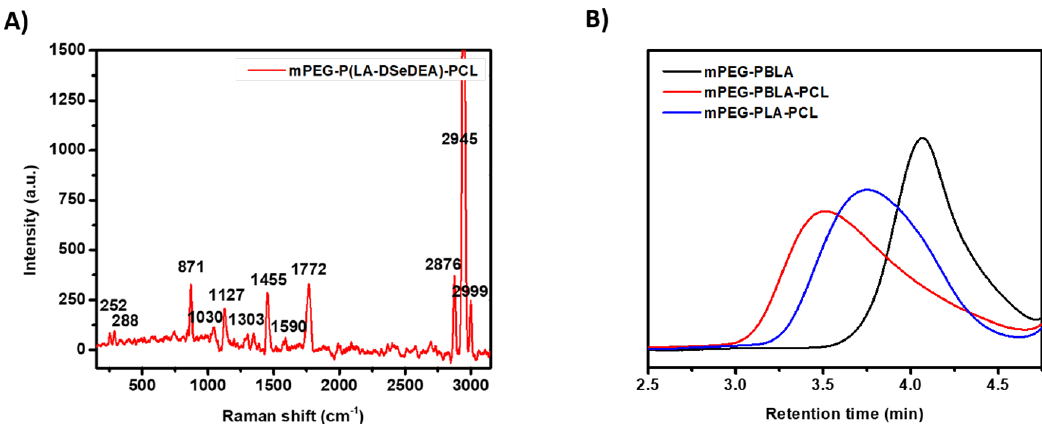
Figure 1. 1 H NMR spectra of mPEG-PBLA ( A ), mPEG-PBLA-PCL ( B ), and mPEG-PLA-PCL ( C ) in DMSO-d 6 ; mPEG-P(LA-DSeDEA)-PCL ( D ) in CF 3 COOD.